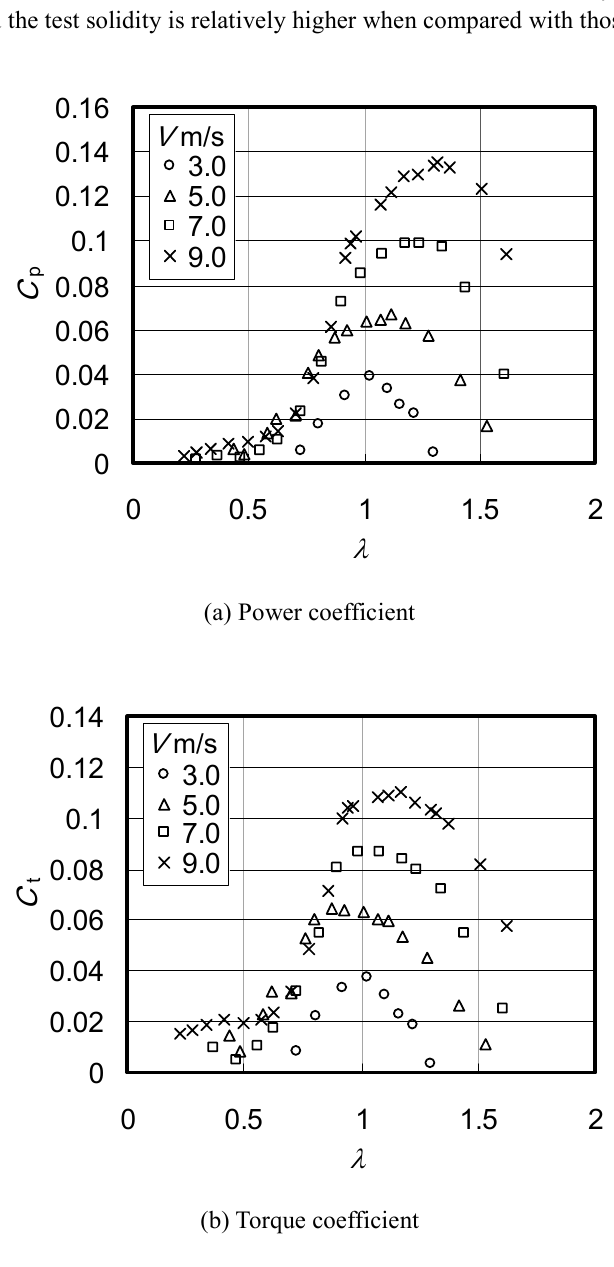
Effect of wind velocity on turbine characteristics ( σ = 1.37, α =